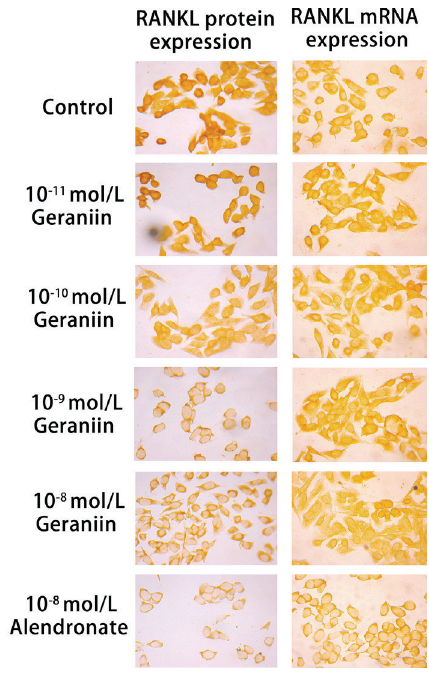
FIGURE 9 - Representative images of immunocytochemistry staining for RANKL protein expression (A) and in situ hybridization staining for RANKL mRNA expression(B). Geraniin (10 -11 -10 -8 mol/L) decreased IOD and MOD values of RANKL mRNA and protein expression in positive